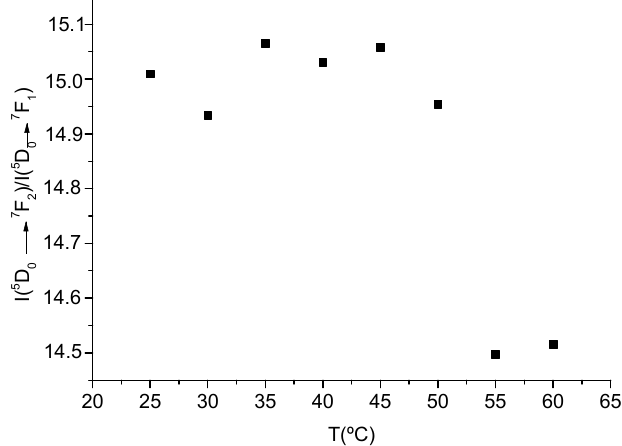
Figure 4. Temperature dependent total integrated intensity of 5 D 0 → 7 F 2 transition relative to the 5 D 0 → 7 F 1 transition band between 25 and 55 °C.